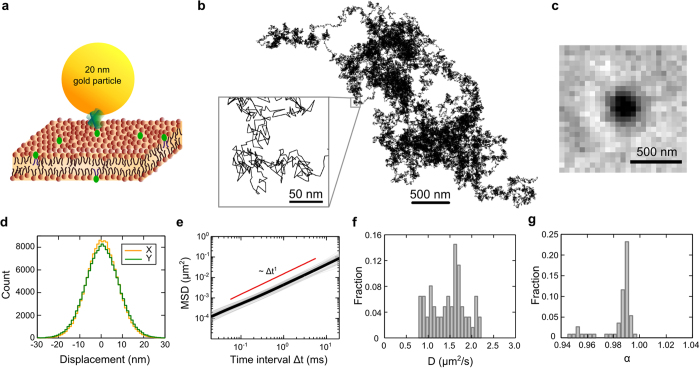
Visualization of single lipid diffusion in homogeneous bilayer membrane via iSCAT SPT with 3 nm spatial precision at 50 kHz.(a) Schematics of 20 nm GNP attaching to single lipid molecule at the headgroup in a membrane for high-speed iSCAT tracking. The particle and the bilayer membrane are plotted at the same scale. (b) Diffusion trajectory of single lipid molecule in a homogeneous membrane recorded at 50 kHz for 3.1 s (see also Movie S1). (c) An iSCAT snapshot of a 20 nm GNP diffusing on the membrane captured at 50 kHz. The spot size is ~300 nm (full width at half maximum), and the SNR is 20. The center of the spot is determined by SPT and the precision of determining the center position is 3 nm. (d) Step size distributions in two lateral directions at 20 μs timescale both show perfect Gaussian distributions. (e) Time-average MSD of 62 diffusion trajectories (grey lines) and their ensemble average (thick black line), showing uniform Brownian diffusion. The red line indicates the linear dependence of the MSD on the time interval Δt as for perfect Brownian diffusion. (f) Histogram of the measured diffusion rate ( = 1.48 ± 0.39 μm2 s−1). (g) Histogram of measured anomalous exponent α. Narrow peak around α = 1 indicates the diffusion in homogeneous membrane is nearly Brownian.